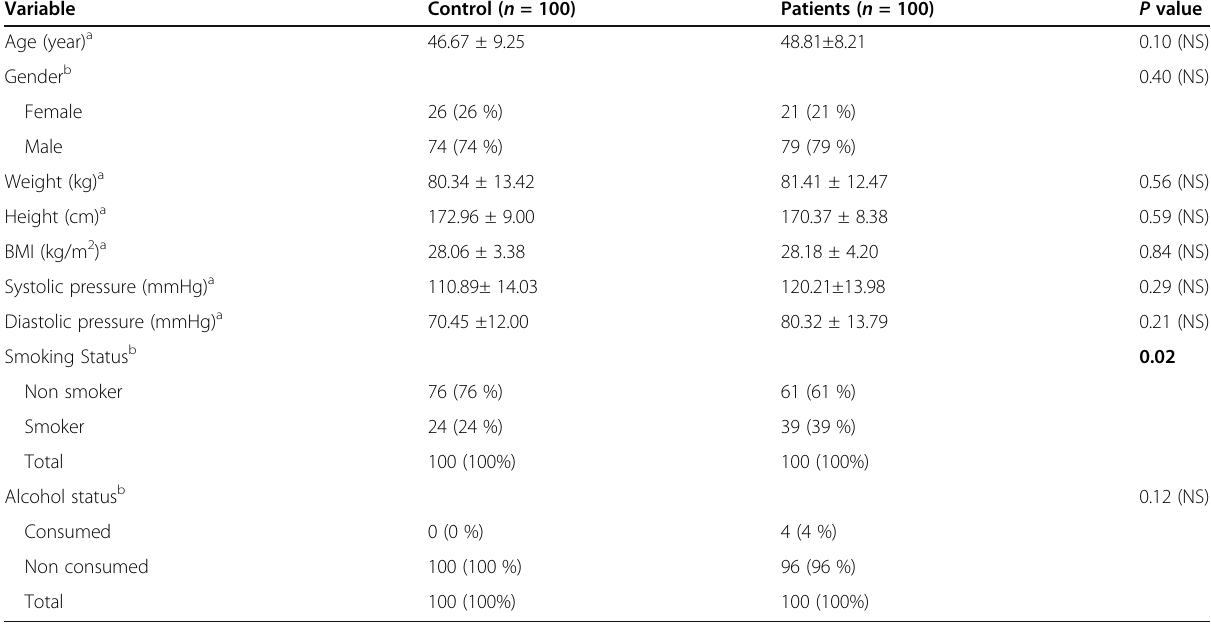
Table 2 Demographic characteristics of the study